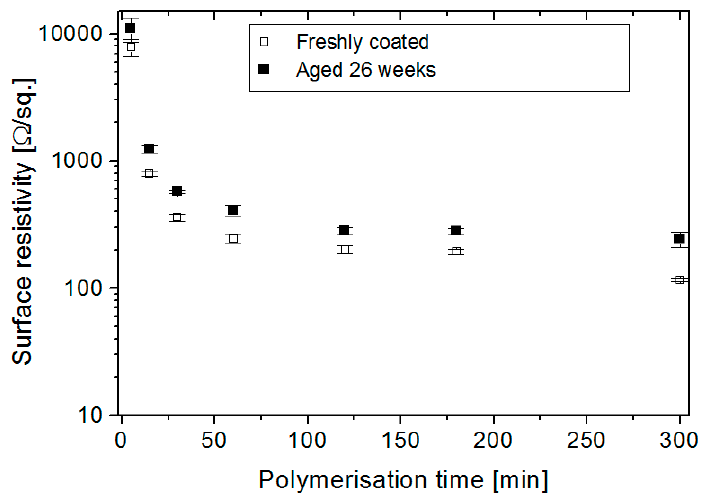
Figure 4. Surface resistivity (R S ) for newly coated and aged (six months) conducting PPy- p TSA–coated Nylon-Lycra as a function of polymerisation time. p TSA concentration: 0.018 mol/L.